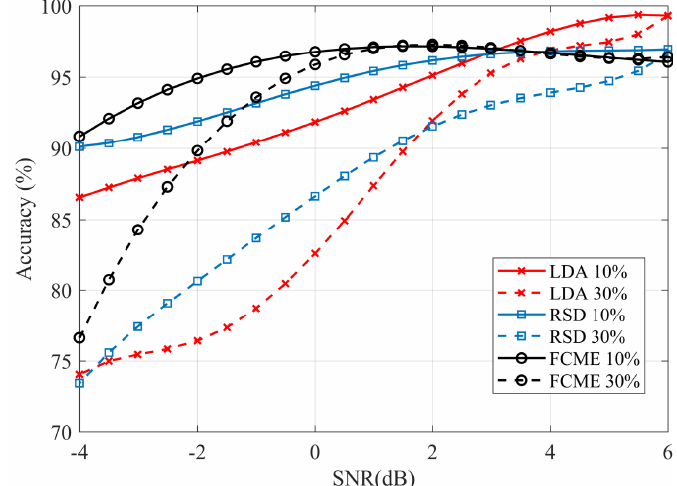
Figure 5. Total detection efficiency as an average ratio of correctly recognized signal-with-noise and noise-only